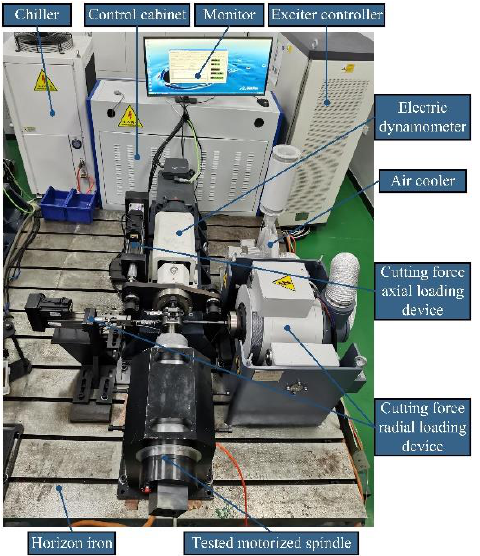
Table 5. Expected test cost and ADT cost